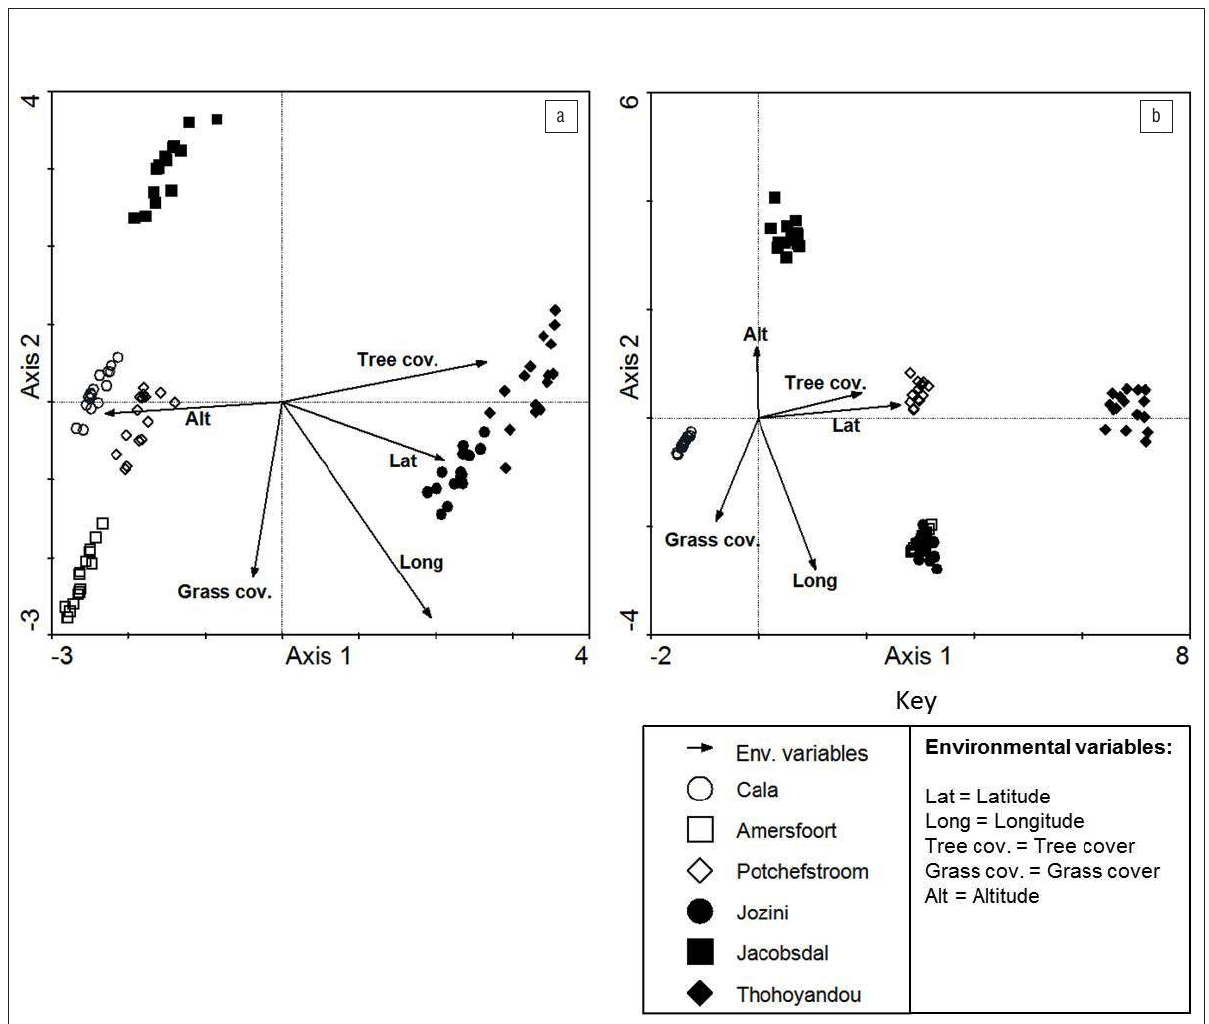
Figure 4: Canonical correspondence ordination of all sampled localities, showing correlations between environmental variables and sampling points for (a) plants and (b) arthropods. Each symbol represents the weighted average of one